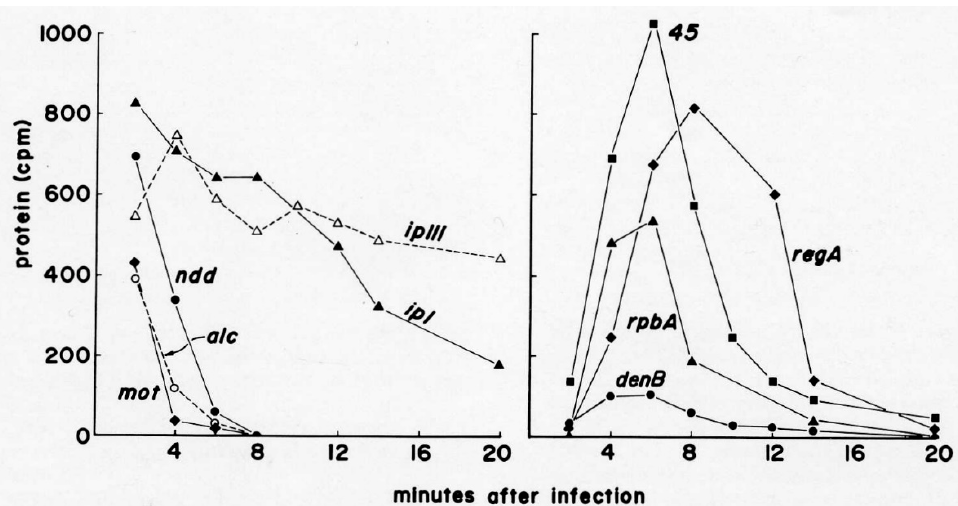
Figure 3. Quantitation of timing and extent of synthesis of various 14C-labeled T4 proteins: Approximate quantification of selected T4 proteins synthesized after infection. The Figure 2 gels were carefully aligned with the autoradiographs, spots for well-separated phage proteins were cut out and counted in a scintillation counter, and the values were corrected for protein size and acrylamide quenching. The actual number of molecules made each period was estimated by integrating the area under each curve and calculating ratios based on estimates in the literature. Koerner et al. reported that T4 makes about 4000 molecules per cell of ndd, used to bind the host genome to the cell wall [20]. Burke et al. estimated that 10,200 molecules/cell were made of gp45, involved in both DNA replication and late transcription [21]. Figure reproduced from [18].